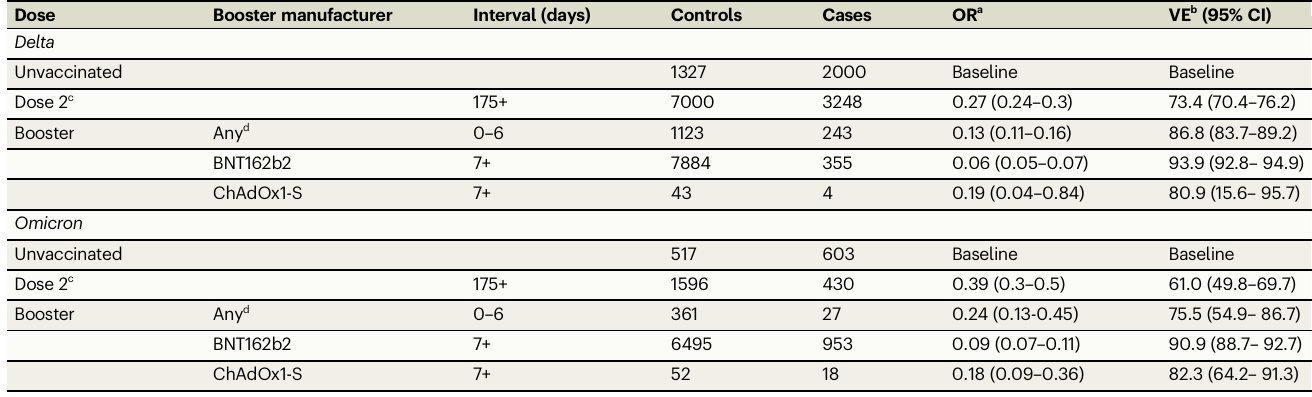
Table 4 | Effectiveness of the ChAdOx1-S and BNT162b2 booster vaccines against hospitalisation as de fi ned by linkage to